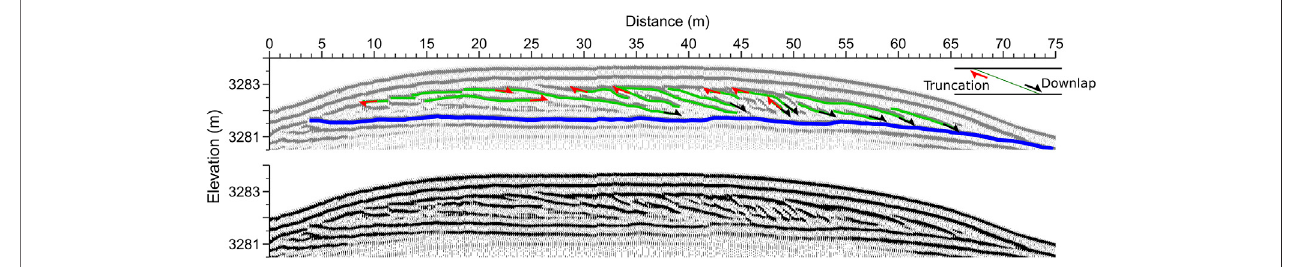
FIGURE2| Aground-penetratingradartransectbisectingthedepositionallobeofBlowoutAfromNWtoSE.Theverticalaxisisexaggeratedbyafactorof2.5.The extractedbaseisdenotedbythethickerbluelineandinterpretationsoftheinternalboundingsurfacesareshownbythinnergreenlines.Theuninterpreted GPRsurveyis shown for